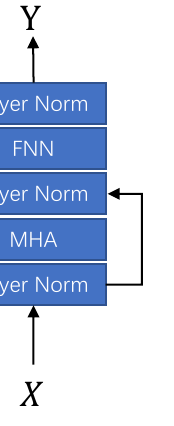
Figure 5. Inner structure of complex sparse transformer.